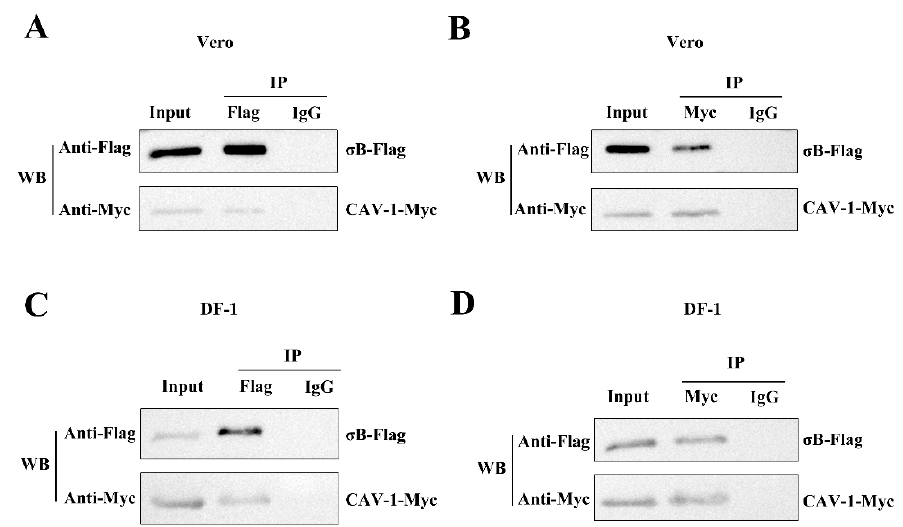
Figure 3. ARV σ B protein interacts with Cav-1. ( A , B ) Co-IP analysis was performed with Vero cells overexpressing Flag- σ B and Myc-Cav-1 at 36 h post transfection. ( A ) Myc-Cav-1 was shown to co- precipitate with the Flag-tagged σ B in Vero cells. ( B ) Flag-tagged σ B was found to co-precipitate with Myc-tagged Cav-1 in Vero cells. ( C , D ) Co-IP assay was performed with DF-1 cells overexpressing Flag- σ B and Myc-Cav-1 at 36 h post transfection. ( C ) Myc-Cav-1 was shown to co-precipitate with the Flag-tagged σ B in DF-1 cells. ( D ) Flag-tagged σ B was found to co-precipitate with Myc-tagged Cav-1 in DF-1 cells.